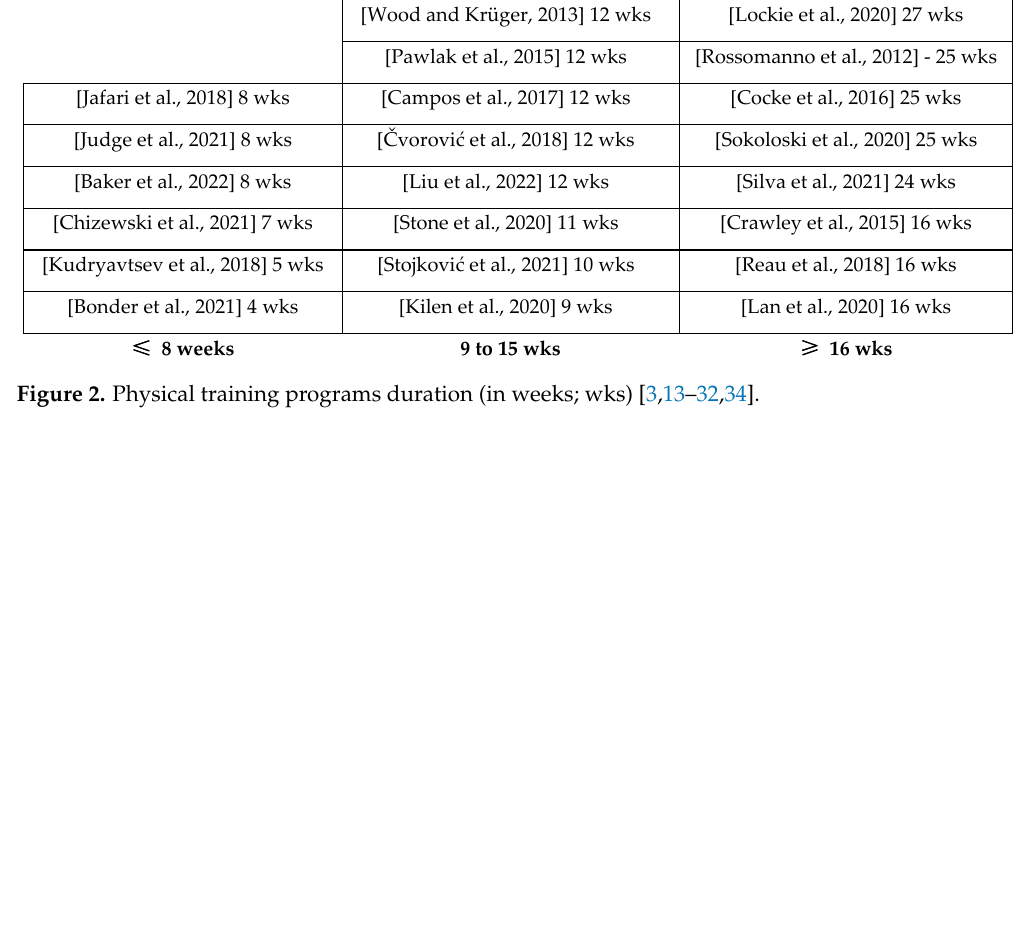
Table 4. Physical training programs distributions.